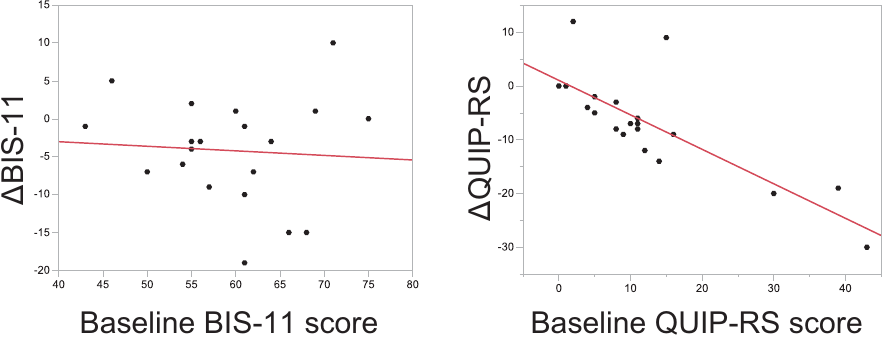
Fig 4. Scatter plot showing the relationship between baseline data and changes after mindfulness meditation program (BIS-11 and QUIP-RS).